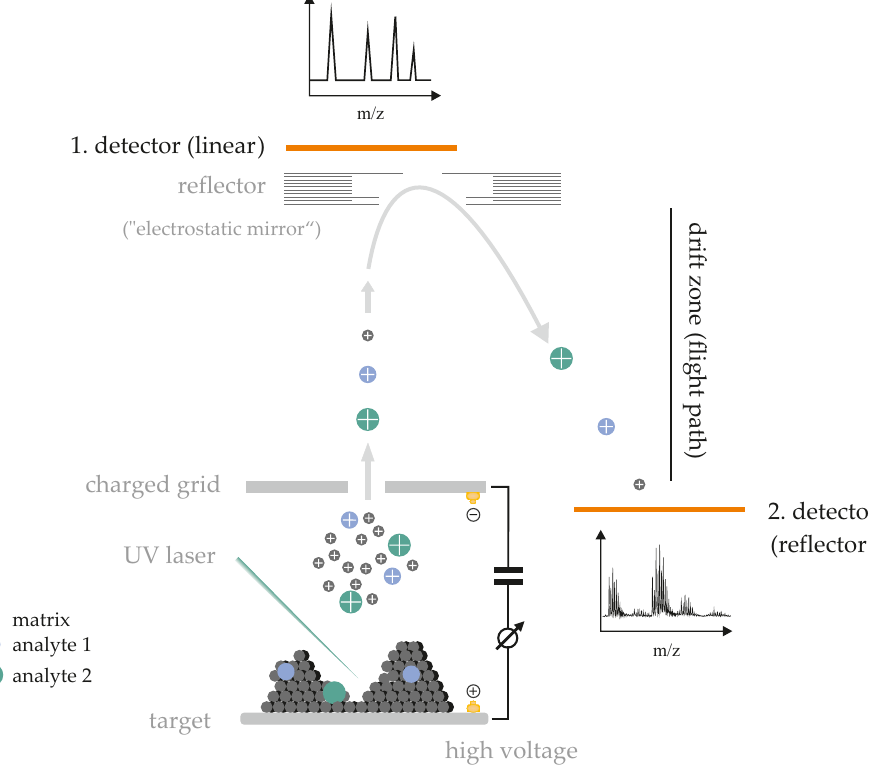
Figure 1. Simplified schema of the positive ionization matrix-assisted laser desorption/ionization-time- of-flight (MALDI-TOF) process occurring in the mass spectrometer (for details see text and Reference [18]). The influence of the detection using either the linear or the reflector mode is emphasized in the